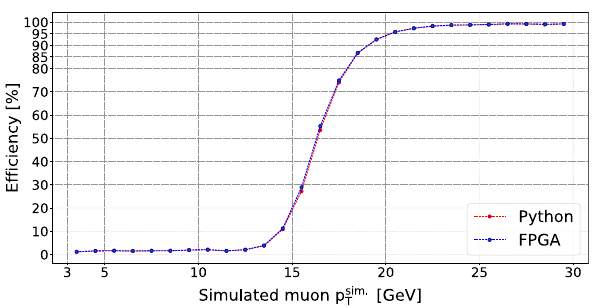
Fig. 17 Muon trigger efficiency plotted as a function of the simulated muon p T for the software (red) and FPGA